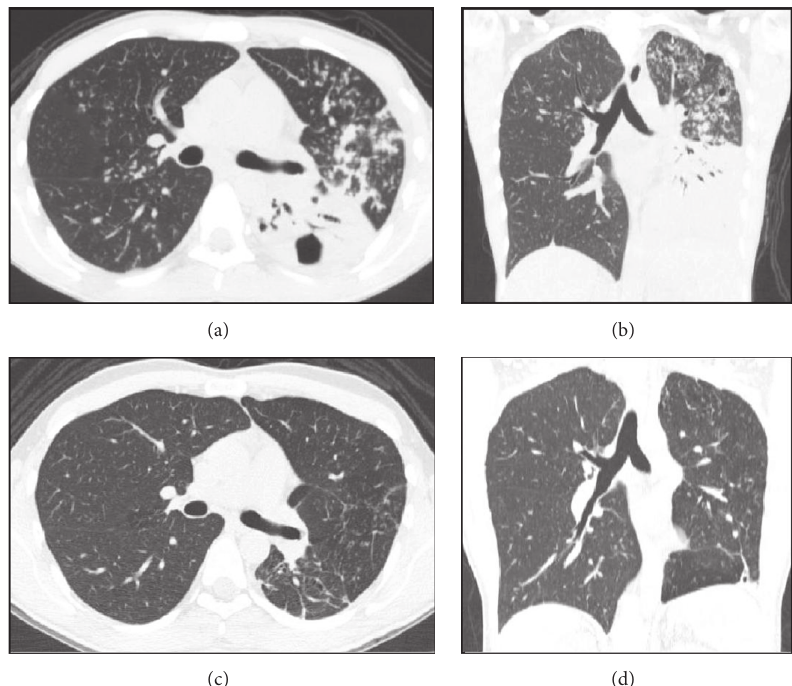
Figure2:ComputedtomographyfindingsinTB.Axialview(a)andcoronalreformatting(b)ofTBbeforetreatment,recordedinparenchymal window, indicating extensive consolidations intermingled with air bronchograms in the left lower lobe, associated with cavitary lesions and draining bronchus, confluent opacities, and bronchogenic dissemination characterized by airway nodules configuring the tree-in-bud pattern observed in the left upper lobe and right lung. Additionally, note the airway changes represented by increased wall thickness and bronchial dilation in the left upper lobe. (c) and (d) show the structural changes observed after treatment, characterized by volumetric reduction of the left lung, architectural distortions, thick bands of fibrous aspect on the left base, and bronchial changes in the left upper